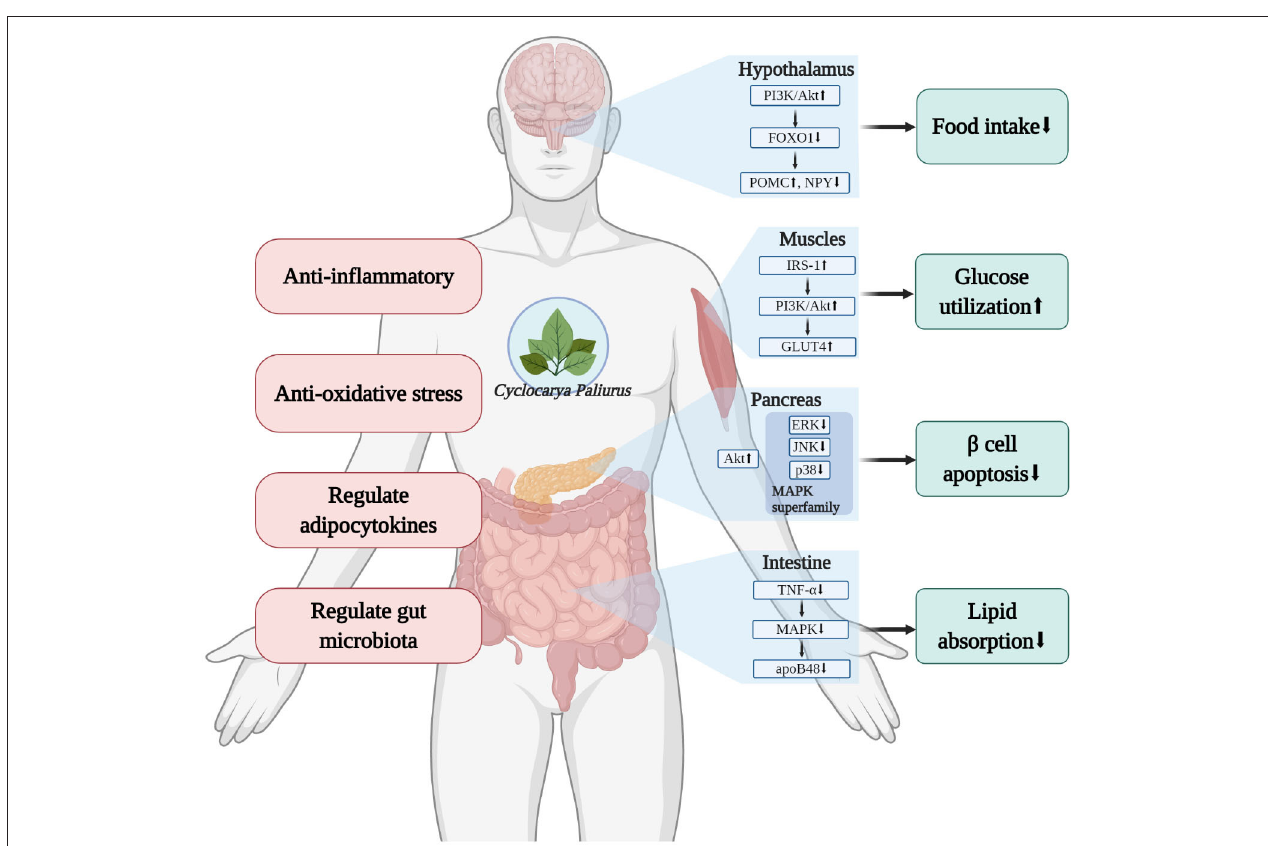
FIGURE 11 | Diagram of the mechanisms investigated for the effect of Cyclocarya paliurus (CP) on glucolipid metabolism (created with BioRender.com).